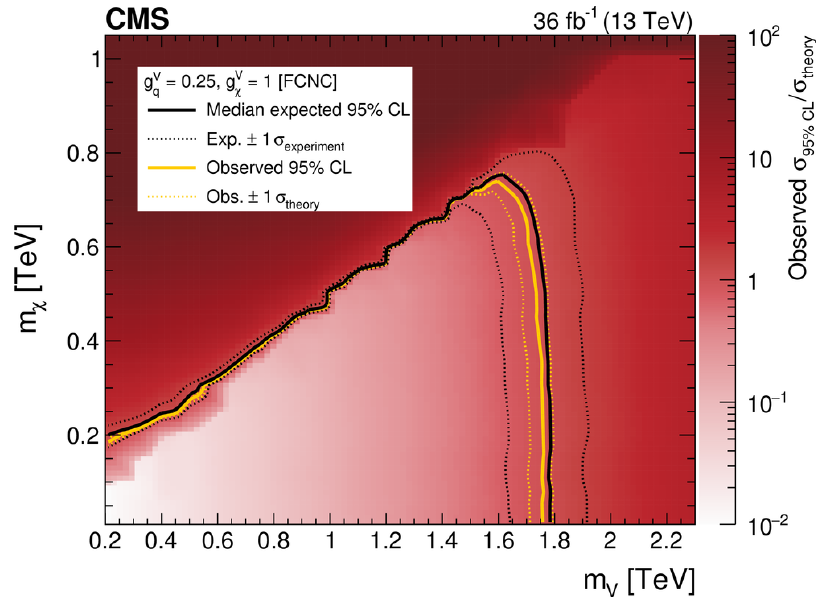
Figure 9 . Results for the FCNC interpretation presented in the two-dimensional plane spanned by the mediator and DM masses. The mediator is assumed to have purely vector couplings to quarks and DM particles. The observed exclusion range (gold solid line) is shown. The gold dashed lines show the cases in which the predicted cross section is shifted by the assigned theoretical uncertainty. The expected exclusion range is indicated by a black solid line, demonstrating the search sensitivity of the analysis. The experimental uncertainties are shown in black dashed